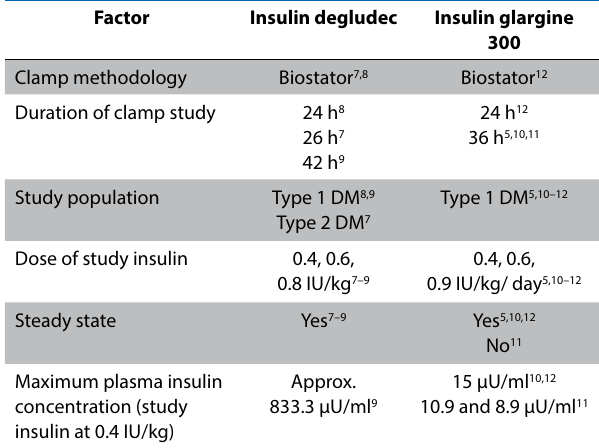
Table 1: Comparison of published glucose clamp results of insulin degludec (IDeg) and insulin glargine U300